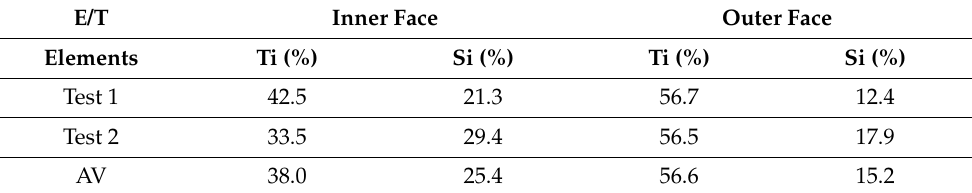
Table 4. Average mass concentration of Ti and Si in AlTiSiN coated specimen.